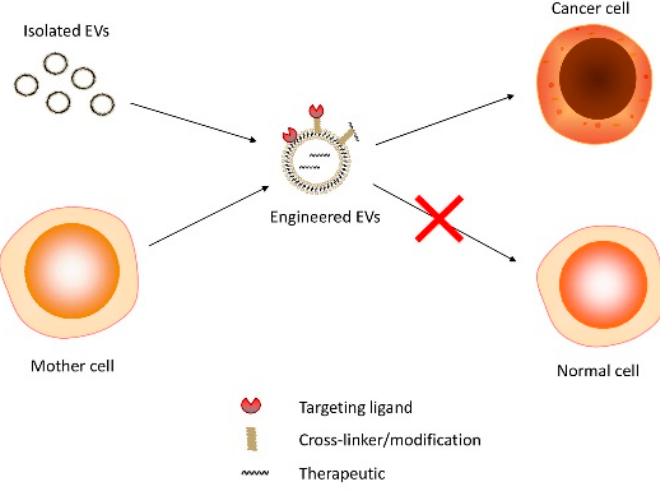
Figure 1. Therapeutic delivery: from source to target